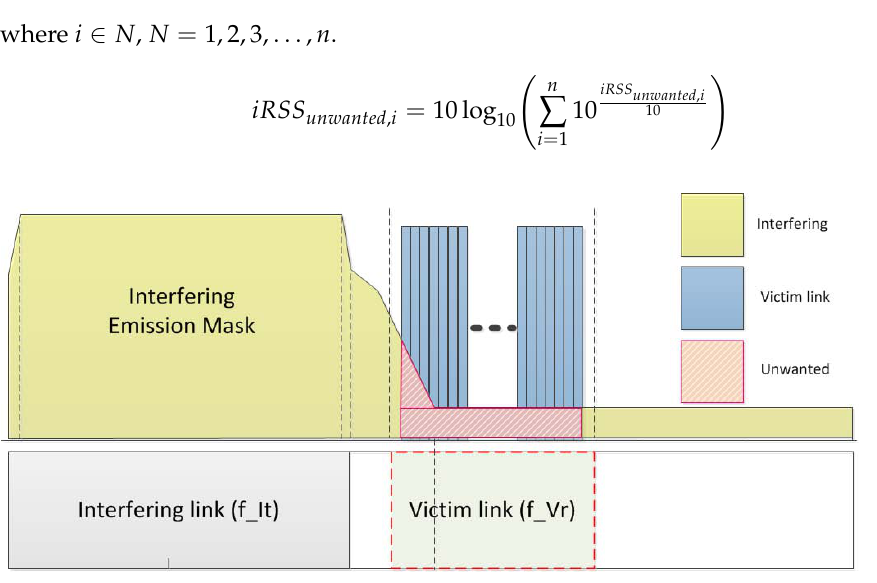
Figure 7. Interference caused by unwanted emission